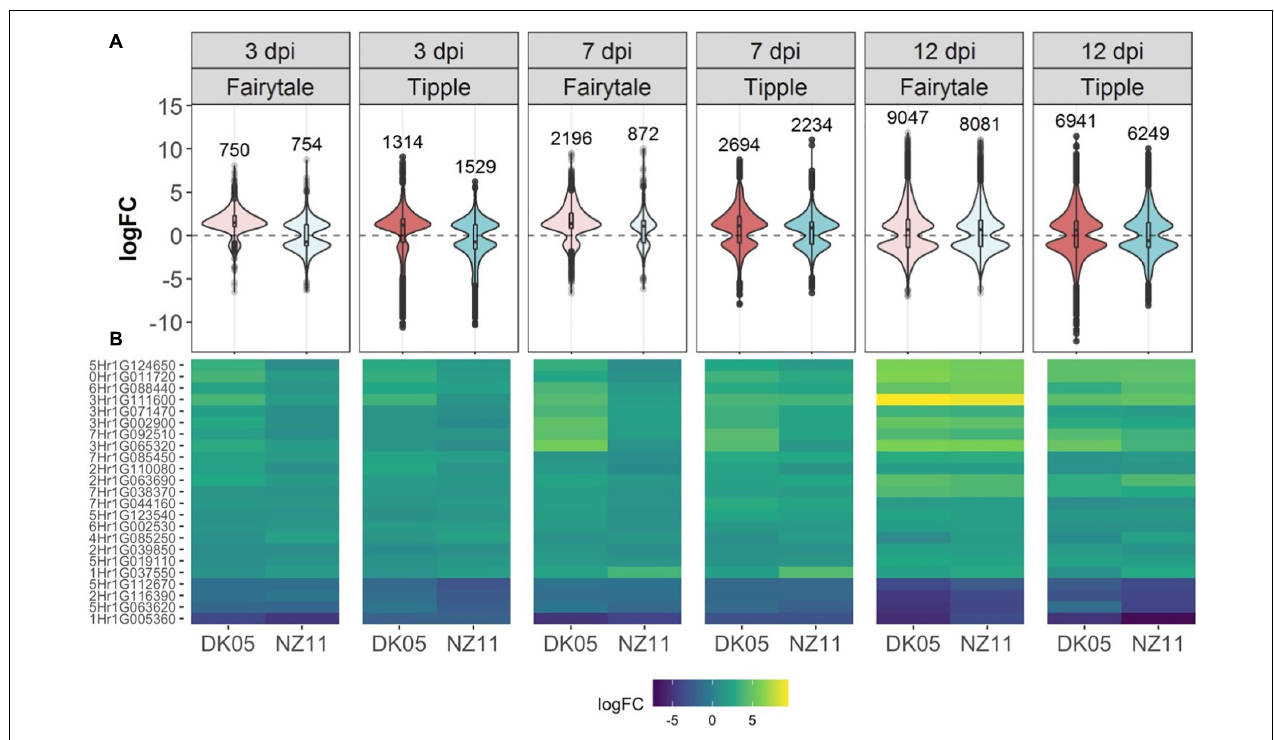
FIGURE 3 | Differentially expressed (DEG) barley genes during Ramularia leaf spot (RLS) disease progression. (A) Violin plots with included box-whisker plots depicting the general trend of up- and down- regulation during RLS progression on barley ( Hordeum vulgare L ) cv Fairytale and cv Tipple during foliar infection with Rcc isolates DK05 and NZ11. (B) Heatmap of differentially expressed (logFC) core genes. Gene IDs are shortened (HORVU